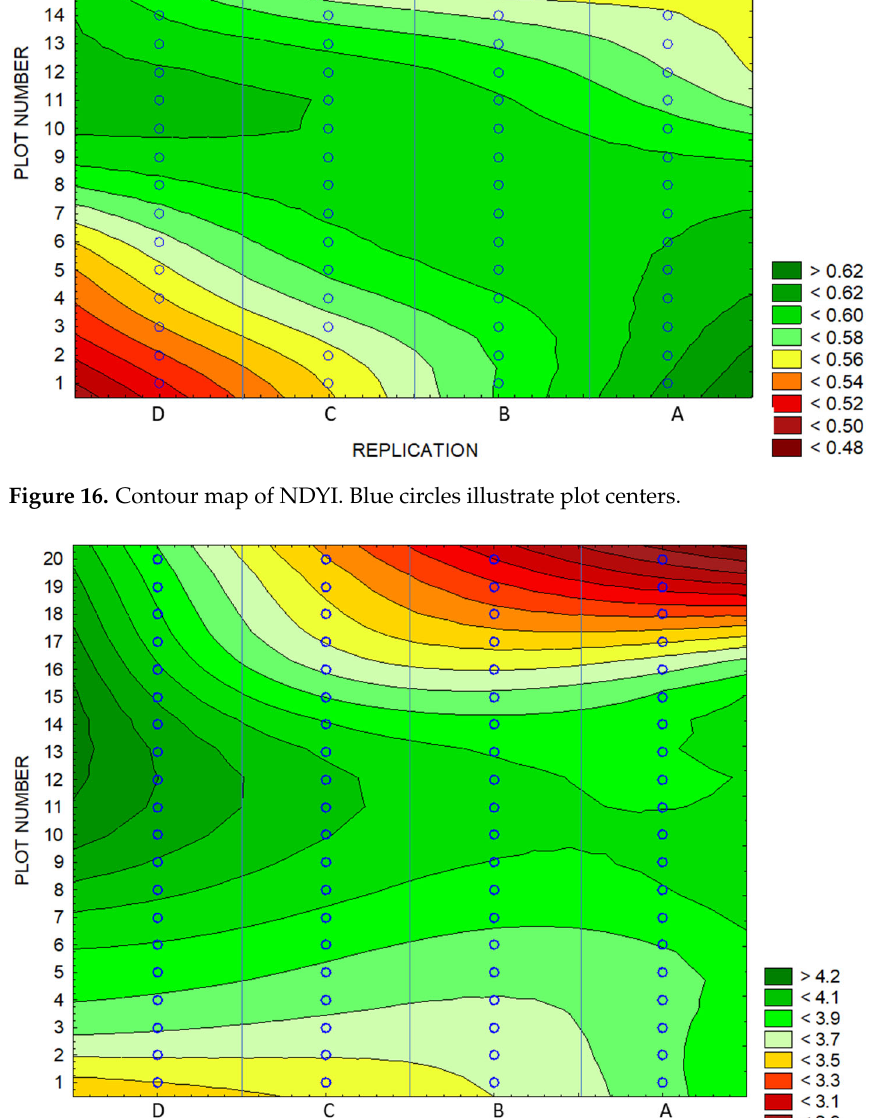
Figure 17. Contour map of yields. Blue circles illustrate plot centers.